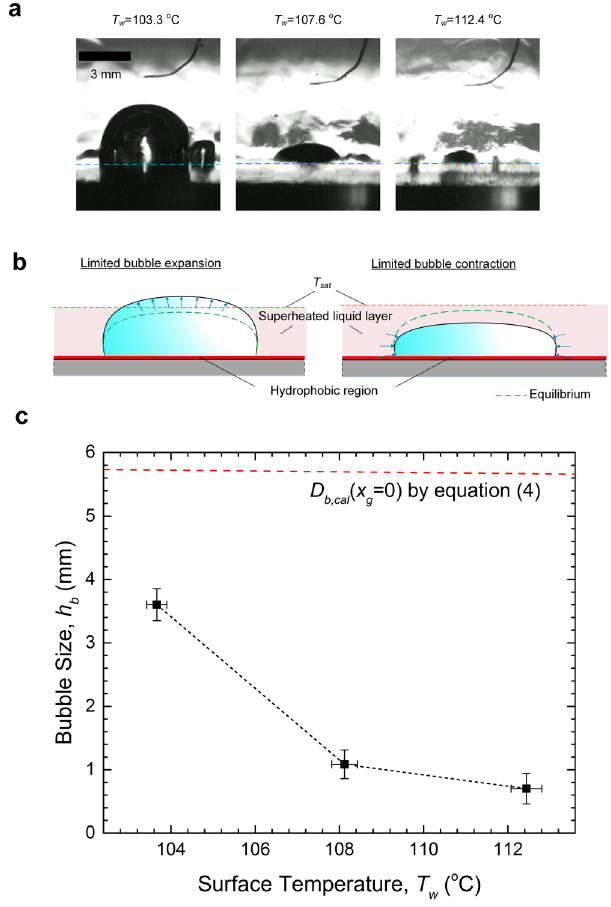
Figure 5. Bubble behaviour in the closed system. ( a ) Evolution of bubble shape with increasing surface temperatures as captured by the high-speed camera. Despite the shrinking size and receding three-phase contact line, the bubble remained immobile on the hydrophobic surface. The light blue dash line represents the boiling surface. See Supplementary Videos M2 for the examples of the oscillatory behaviour of the interface. ( b ) Oscillations of the bubble cap explained by the dynamic equilibrium between evaporation and condensation. The growth of the bubble is vertically confined within a superheated liquid layer above the heat transfer surface. That is because any excess bubble expansion is limited by condensation by the subcooled bulk, and excess contraction by increased evaporation at the base of the bubble. ( c ) Plot of the distribution of the time-averaged (vertical) bubble size, h b , over various T w . The continuous shrinkage of the bubble was for the most part due to the thinning of the superheated liquid layer under increasing surface heat fluxes. For comparison, calculations of the bubble departure diameter by equation (4) in the limit of x g = 0 are included (red dash-dot line), which shows that without dissolved gas, the bubble never achieved the minimal size needed for the buoyancy force to overcome the hold of the bubble by the surface. The error bars represent the standard deviations of the transient measurements. For detailed transient data, refer to Supplementary Fig.